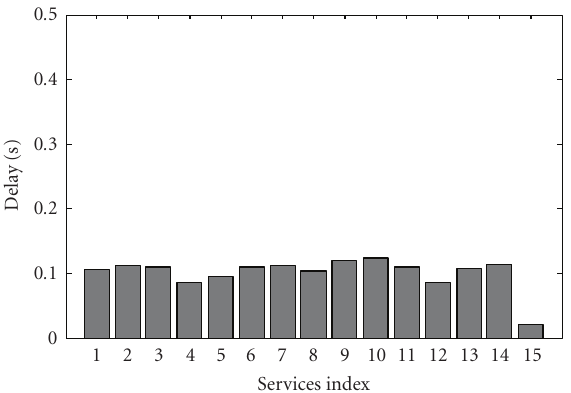
Figure 14: Histogram of minimum bu ff ering delay in StatMux for the service used in Figure 13.